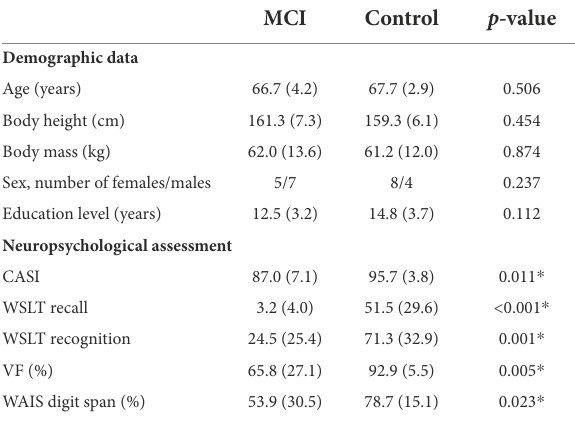
TABLE 1 Means (standard deviations) of the demographic characteristic and neuropsychological assessment results for patients with mild cognitive impairment (MCI, n = 12) and healthy controls (Control, n =